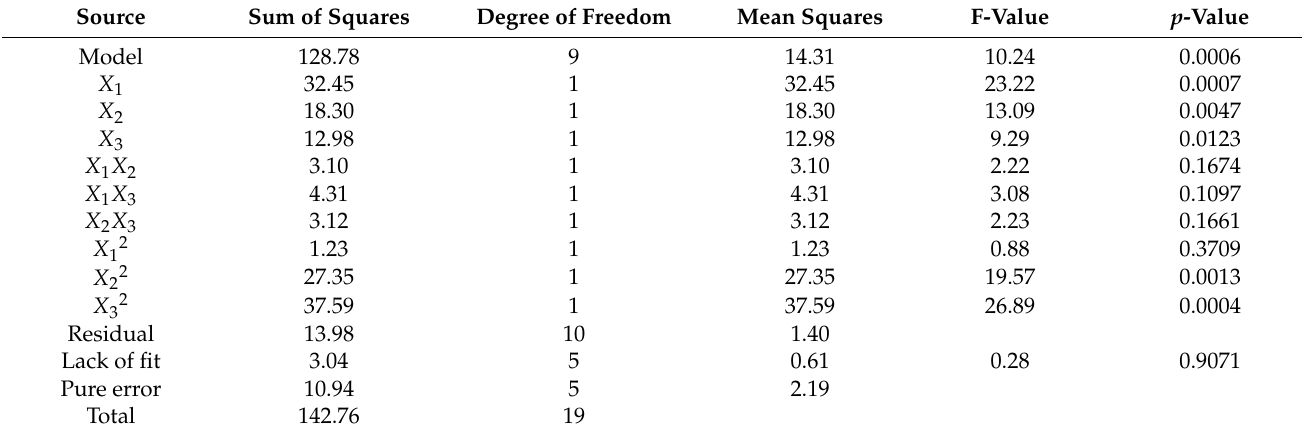
Table 4. Analysis of variance (ANOVA) for response surface quadratic model on